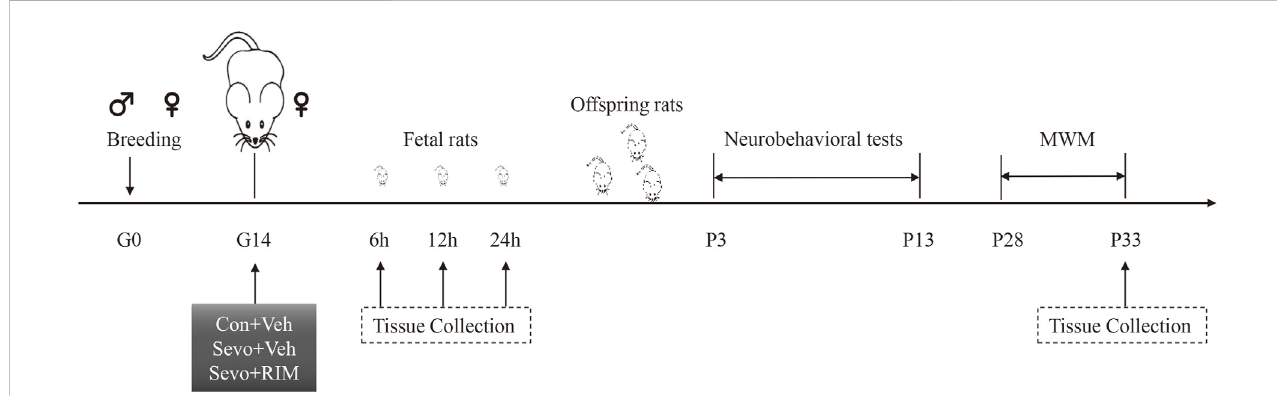
FIGURE 1 Schematic timeline of this research. Pregnant rats received 2-h exposure of 3.5% sevo fl urane or air in the day 0 of gestation (G0). Thirty min prior to sevo fl urane or air exposure, rats were subjected to intraperitoneal injection with Rimonabant (RIM, 1 mg/kg) or vehicle (Veh). Brain tissues were harvested from fetal rats at 6, 12, or 24 h subsequent to sevo fl urane exposure. The offspring rats in each group were employed for neurobehavioral tests and Morris water maze (MWM) tests during P3 – 33. Next, the hippocampus was harvested 1 h after MWM